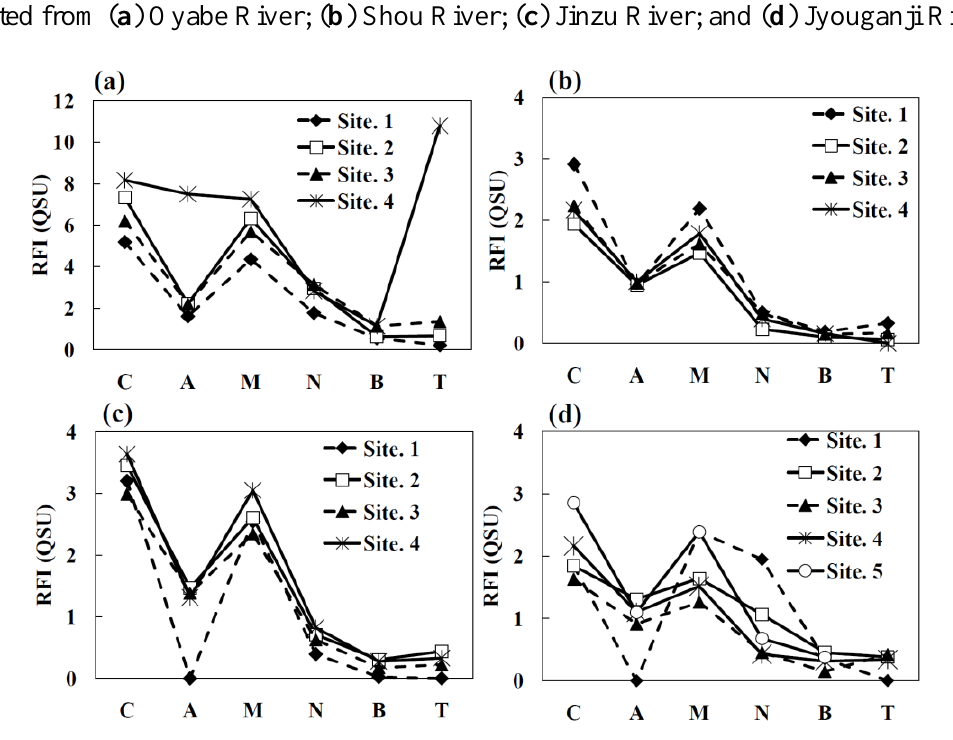
Figure 4. The patterns of RFI values at six fluorescent peaks (peak C, peak A, peak M, peak N, peak B and peak T) obtained from 3DEEM spectra for each water sample